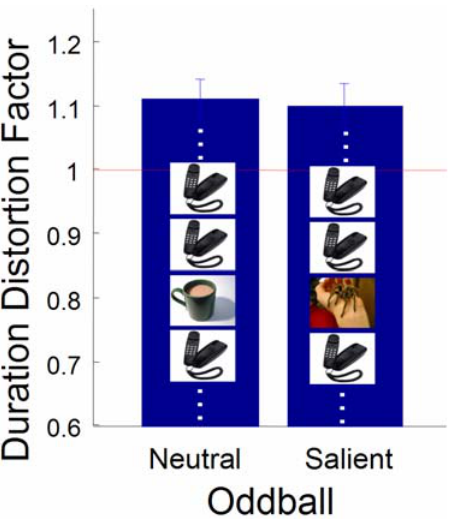
Figure 3. Increasing the emotional salience of the oddball does not increase the effect. DDF values across the two categories of trials– neutral standards with neutral oddball (e.g., coffee cup) and neutral standards with salient oddball (e.g. tarantula). DDF neutral odd- ball=1.112, DDF salient oddball=1.098, p=0.65. Error bars S.E.M.